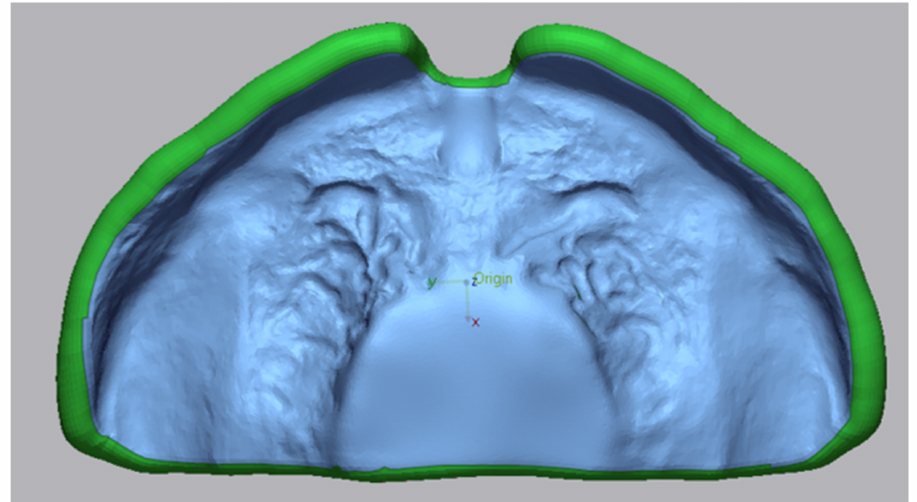
Figure 5. Selection of comparison area (blue) in the reference file for the superimposition process in Geomagic Control X